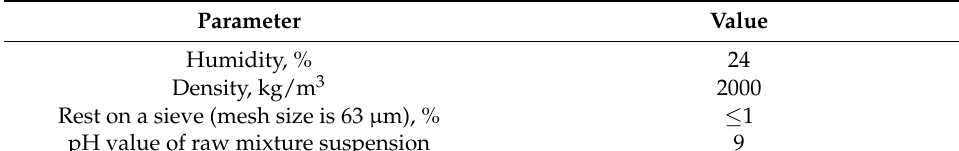
Table 3. Physical and mechanical characteristics of GMM.